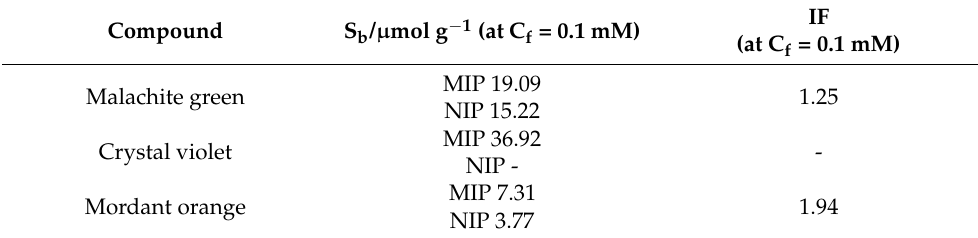
Table 4. Binding capacities (S b ) for malachite green, crystal violet, and mordant orange at C f = 0.1 mM, and their corresponding imprint factors (IF). Values were drawn directly from the fitted curve of each MIP/NIP at the defined concentration